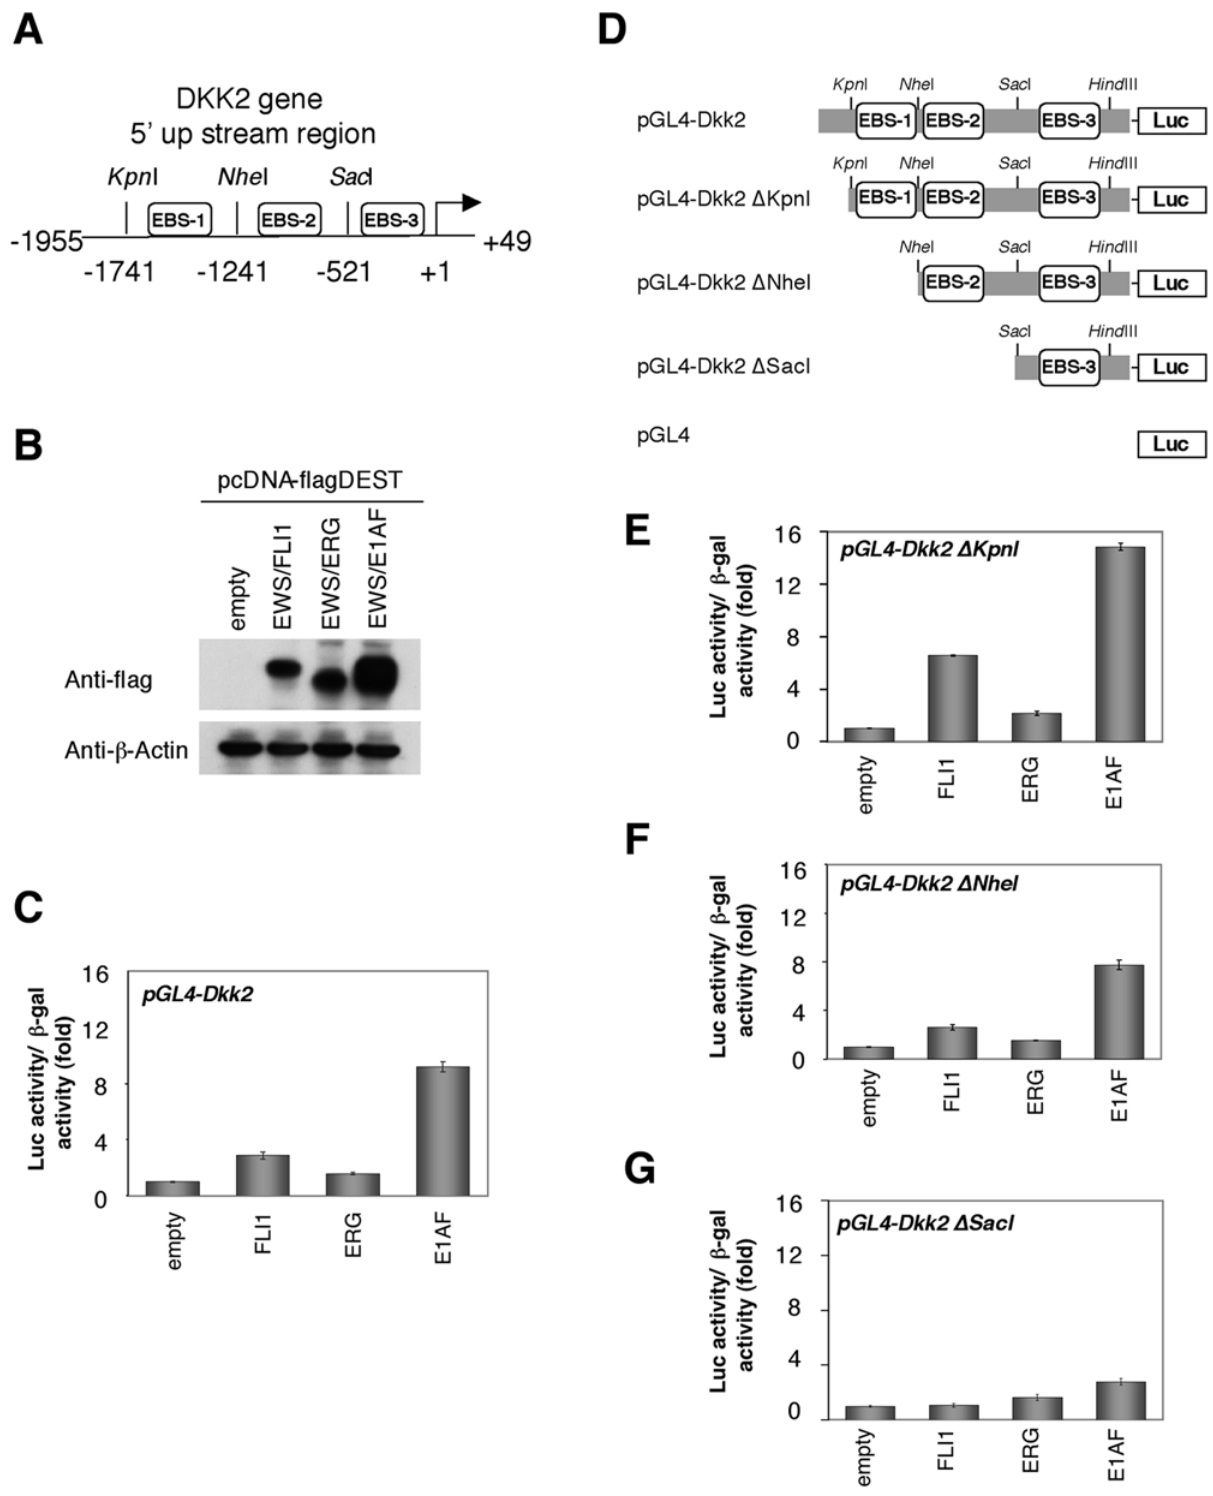
Figure 2. The effect of EWS/ETS expression on the activity of the DKK2 promoter. A , Schematic representation of the 5 9 upstream region of the DKK2 gene. The nucleotide numbering represents the distance from the translation start site ( + 1). Kpn I ( 2 1741), Nhe I ( 2 1241), and Sac I ( 2 521) sites were used to construct a series of deletion mutants of the DKK2 promoter (see Materials and Methods). Consensus ets binding sites are boxed (EBS-1, EBS-2 and EBS-3). B , Western blot analysis for EWS/ETS expression. HEK293 cells were transiently transfected with pcDNA3-flagDEST or pcDNA3-flagEWS/ETS and then analyzed by anti-flag Western blotting. C , The effect of EWS/ETS expression on the activity of the DKK2 promoter. HEK293 cells were co-transfected with reporter plasmids and the expression vector. Luciferase activity was measured after 48 hours. Data are relative values with the SD for triplicate wells. Data are normalized to the value for the empty vector (pcDNA3-flagDEST) which is arbitrarily set to 1. The